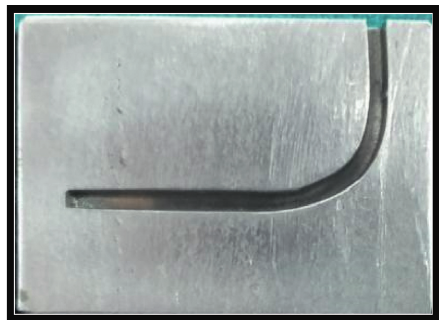
Figure 1: Custom-made metal block simulating curved canal with a degree of curvature 90 ° .